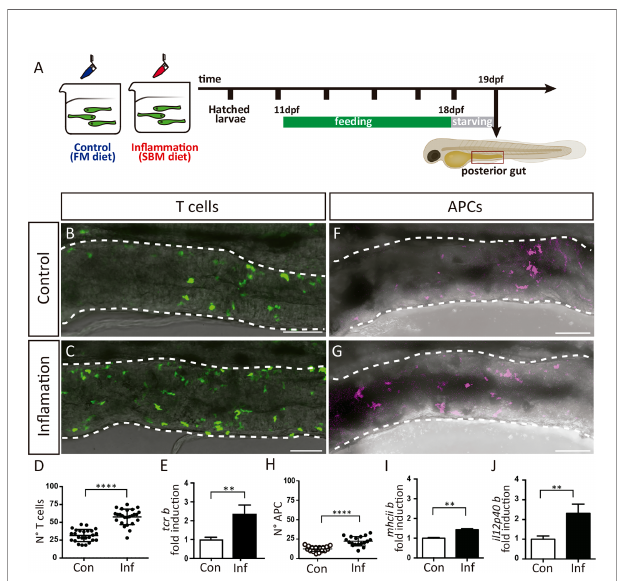
FIGURE 2 | T cells and APCs response during intestinal in fl ammation. (A) Experimental strategy. Larvae were fed 8 days either with a control diet (FM) to maintain homeostasis, or with an in fl ammatory diet (SBM) to trigger in fl ammation (Inf). After a period of 12h of starvation, larvae were processed according to the different analysis. (B, C) Representative images showing the posterior intestine of a Tg(lck:GFP) fi sh in control and in fl ammatory condition. T cells are recognized by GFP expression. (D) Quanti fi cation of the number of GFP+ T cells in the posterior intestine in control and in fl ammatory condition. (E) Fold of mRNA induction of tcrb in the in fl ammatory condition respect to the control condition. The data was normalized against elongation factor 1- alpha ( ef1a ) gene. (F, G) Representative images showing the posterior intestine of a Tg(il12p40b:mTq2) fi sh in control and in fl ammatory condition. Antigen presenting cells (APC) are recognized by mTq2 expression. (H) Quanti fi cation of the number of mTq2+ APC in the posterior intestine in control and in fl ammatory condition. (I, J) Fold of mRNA induction of il12p40b and mhciib in the in fl ammatory condition respect to the control condition. The data was normalized against elongation factor 1-alpha ( ef1a ) gene. Statistical analysis was performed with the Mann-Whitney U test. **p < 0.01 and ****p < 0.0001. Scale bars 50µm. All assays were performed at least three independent